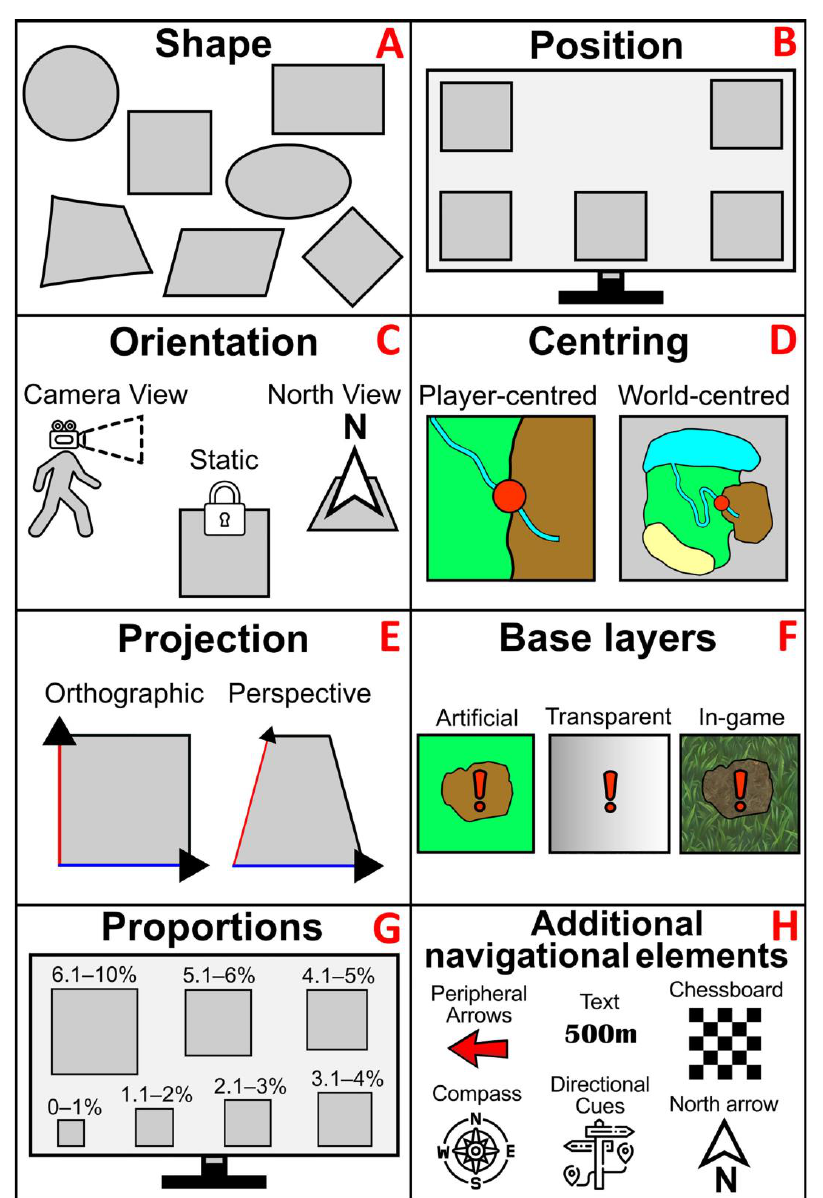
Figure 2. Parameters and attributes for 8 mini-map features according to the chosen 100 video games (( A ) shape, ( B ) position, ( C ) orientation, ( D ) centring, ( E ) projection, ( F ) base layers, ( G ) proportions, ( H ) additional navigational elements).